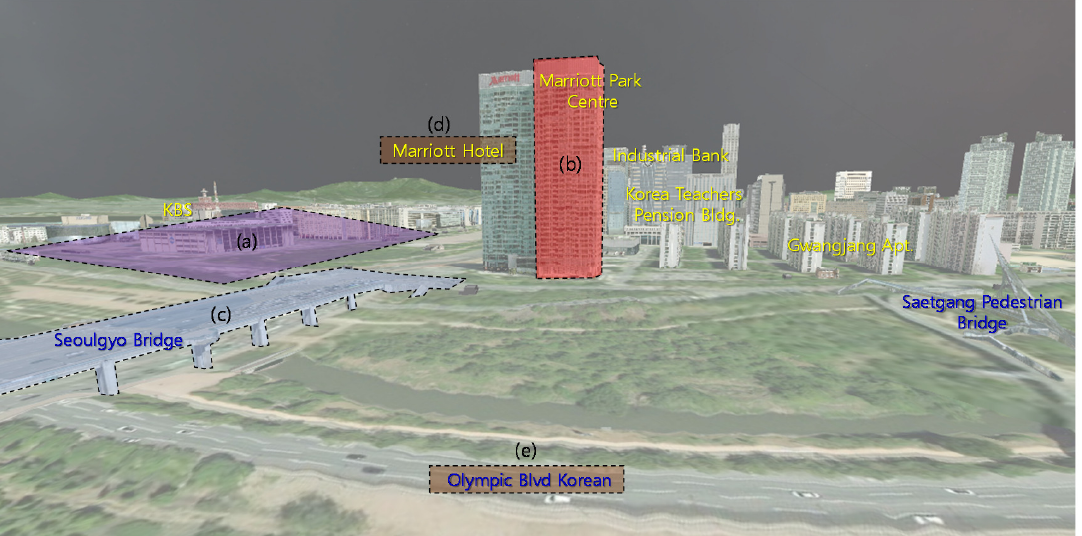
Figure 5. Example of the results of 3D rendering using our urban digital twin model: one of each type of layer data is indicated by the dotted lines. ( a ) A 3D terrain tile model generated by combining an aerial image and a digital elevation model; ( b ) a 3D building model; ( c ) a 3D bridge model; ( d ) facility name; ( e ) road name.